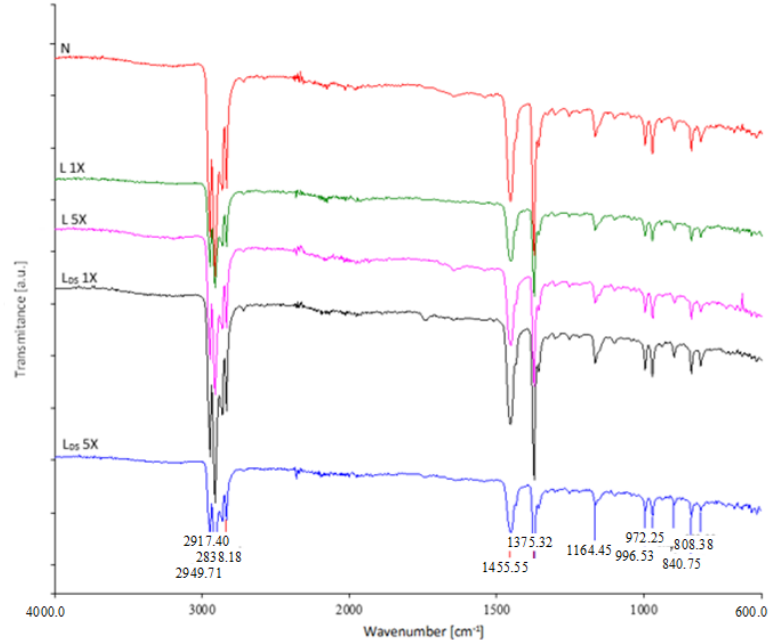
Figure 9. FTIR spectra of the back nonwoven layers of the medical mask before and after the first and fifth washing cycle.